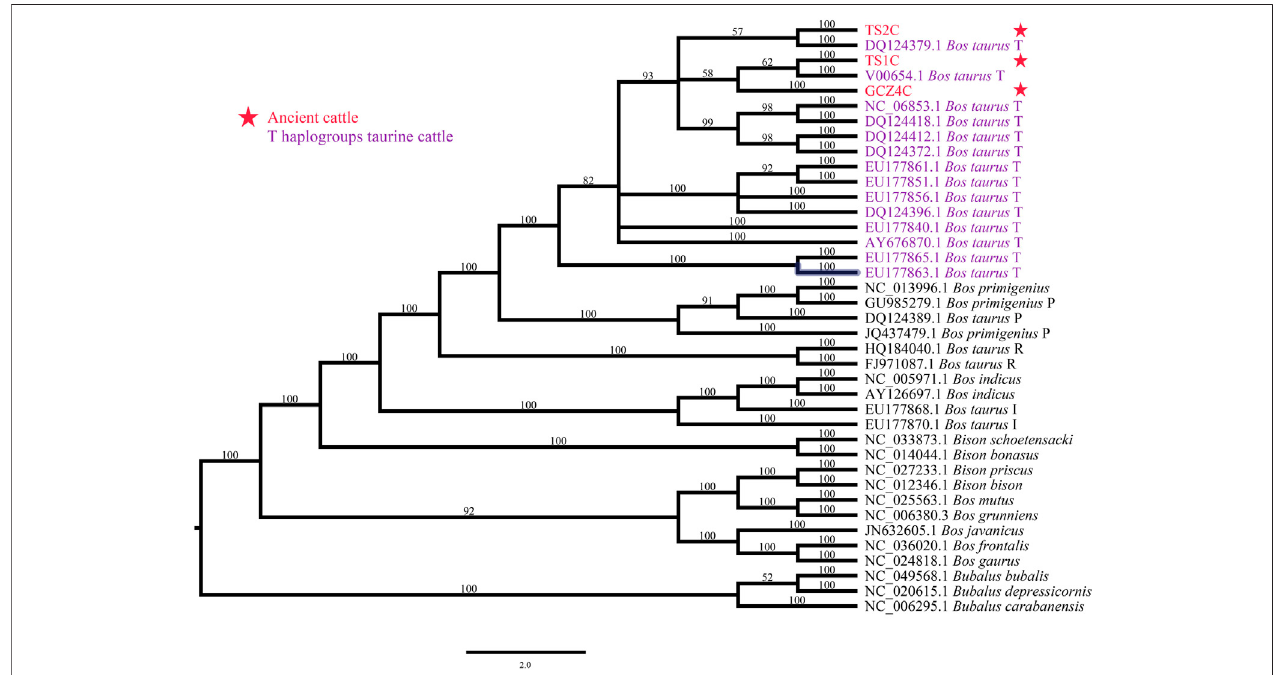
FIGURE 2 | Species identi fi cation though phylogenetic analysis. ID marked with red font and star represents the ancient sample, ID with purple font represents T-haplogroup taurine cattle.